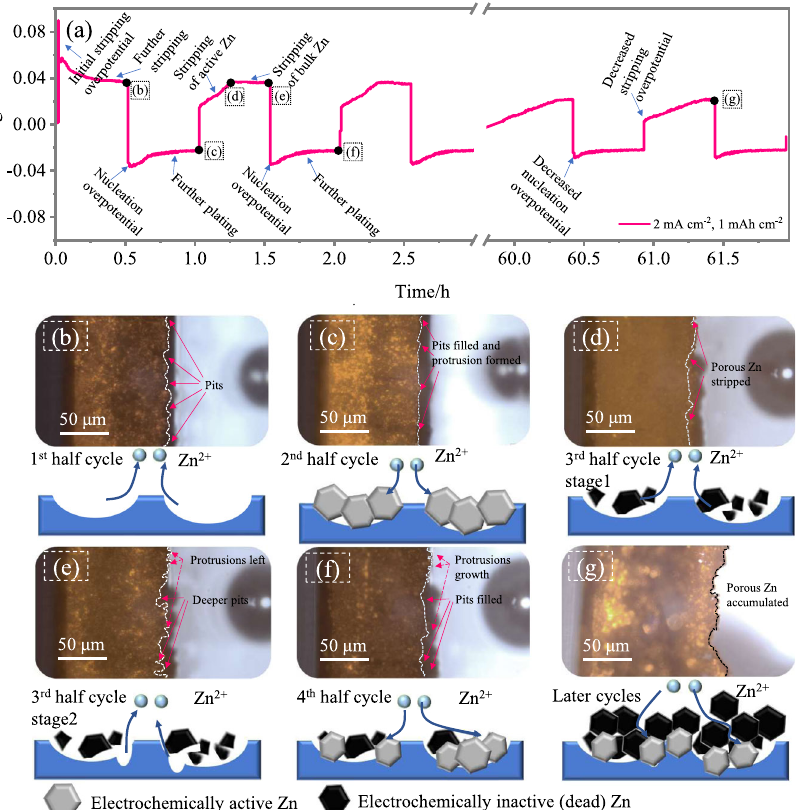
Fig. 2 Potential pro fi les and morphology evolution of the initially stripped Zn metal electrodes. a Voltage evolution of S-Zn. b – g Optical micrographs and the corresponding schematic fi gures depicting the morphology of the positions marked in ( a